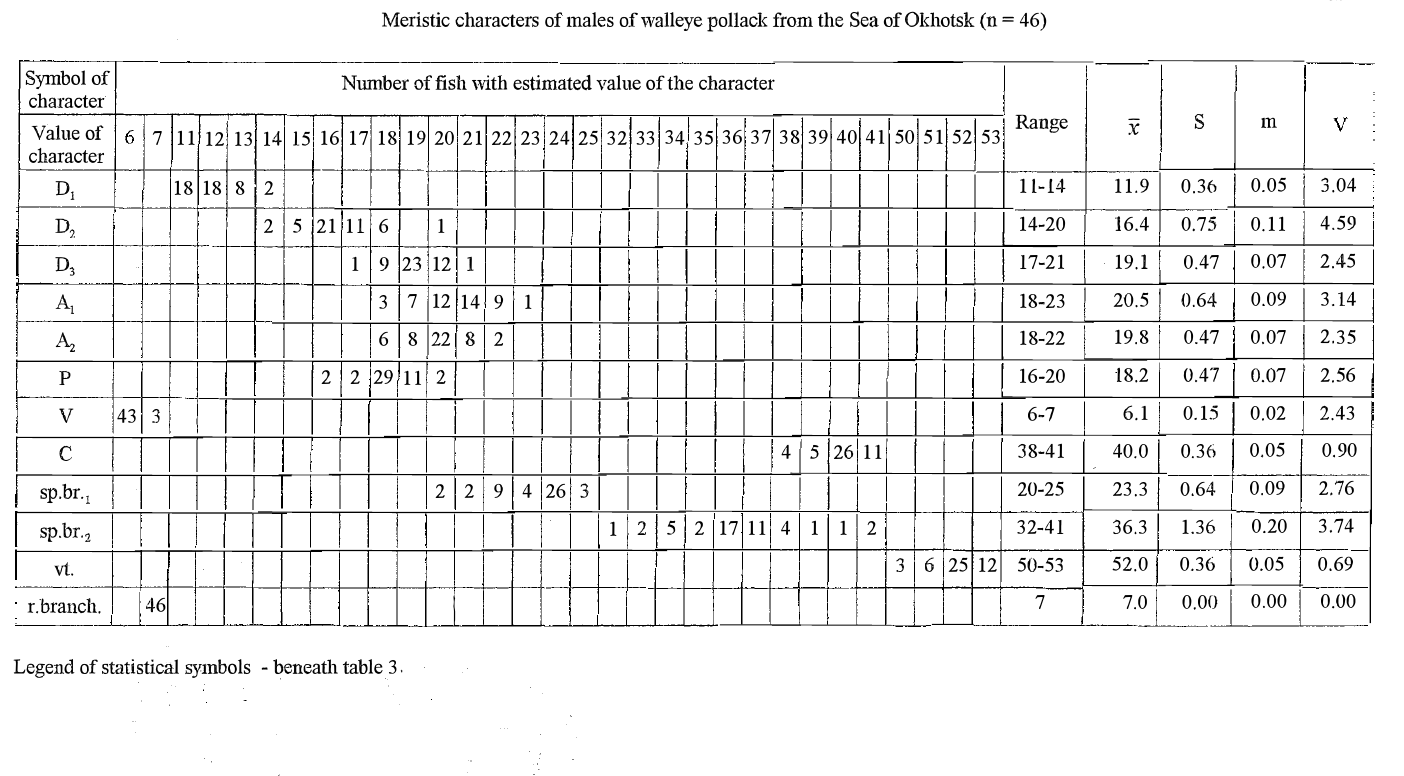
Legend of statistical symbols -beneath table